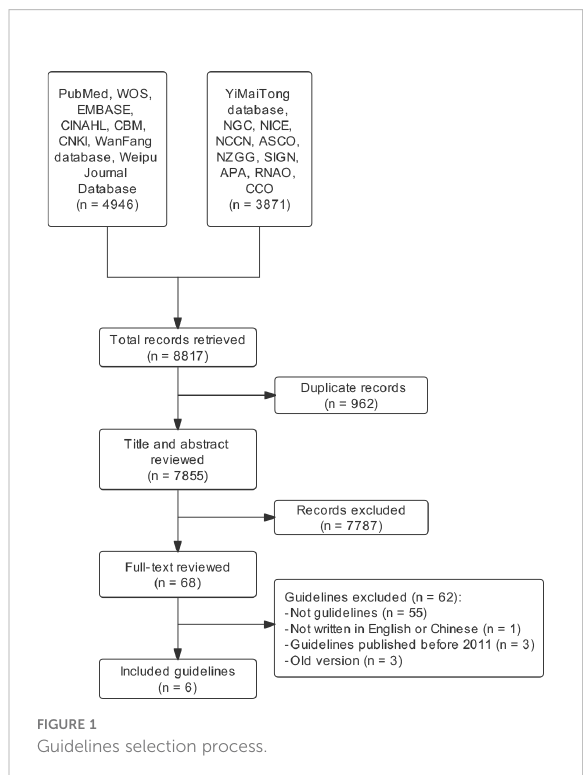
FIGURE 1 Guidelines selection process.